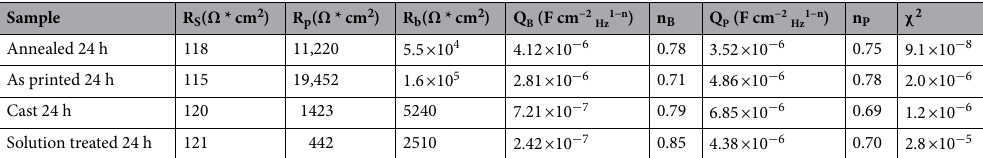
Table 5. Results of the fitting of the experimental data coming from EIS tests on the samples after 24 h of immersion.